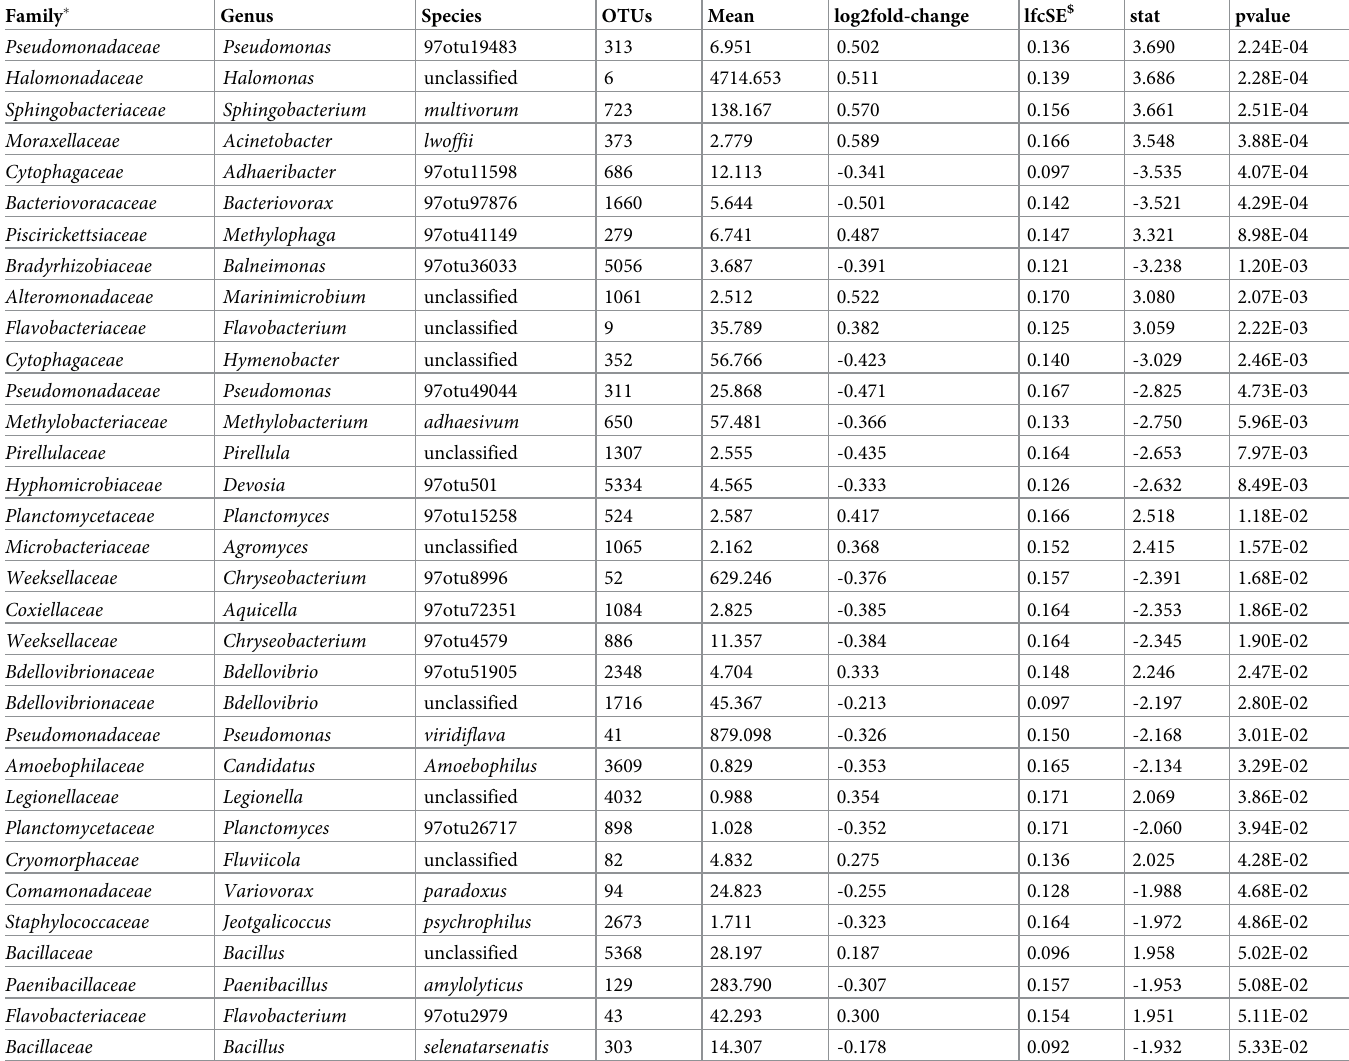
Table 3. Effect of salinity on bacterial species during the three growing